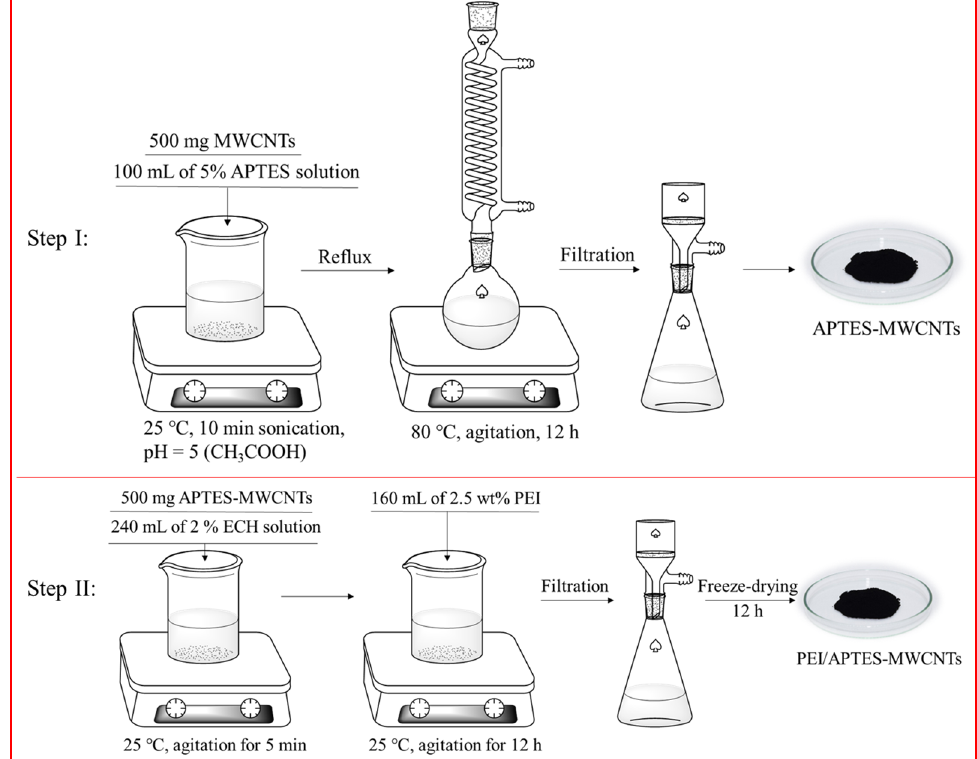
Figure 10. Scheme of the process of PEI/APTES-MWCNTs preparation.